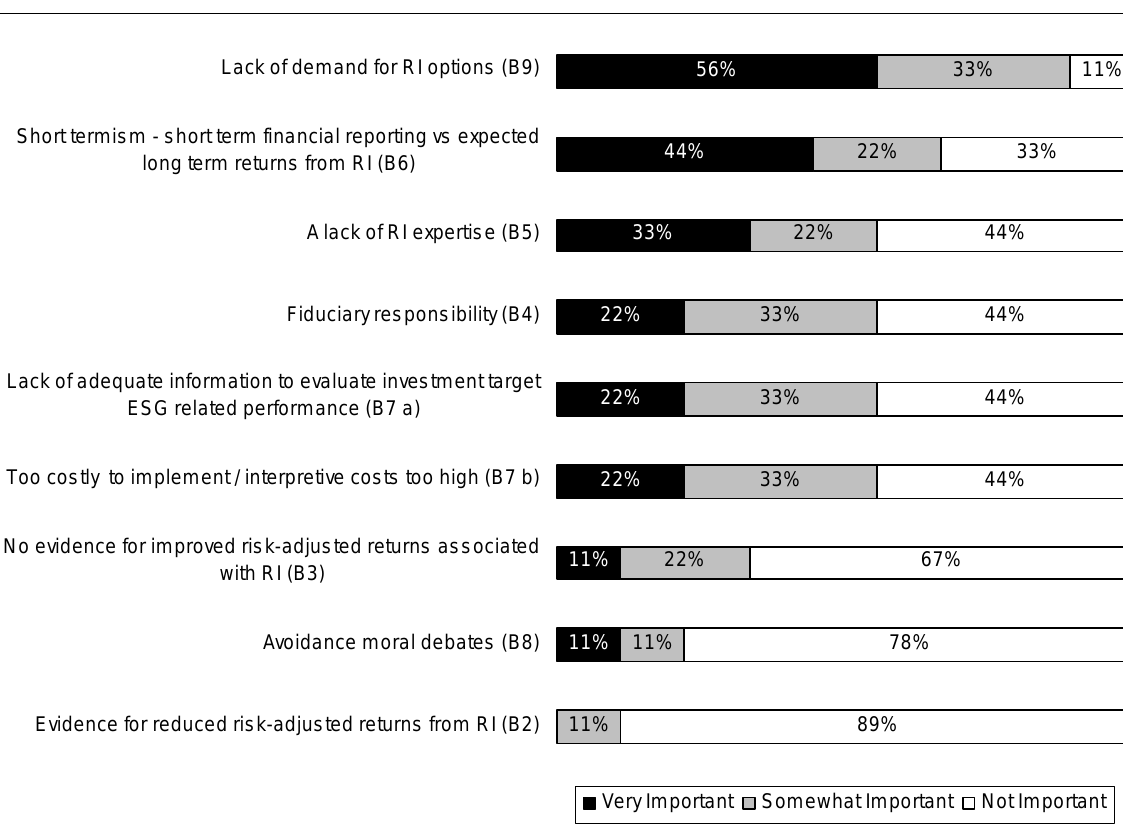
Figure 3: Advisory service providers - Barriers to